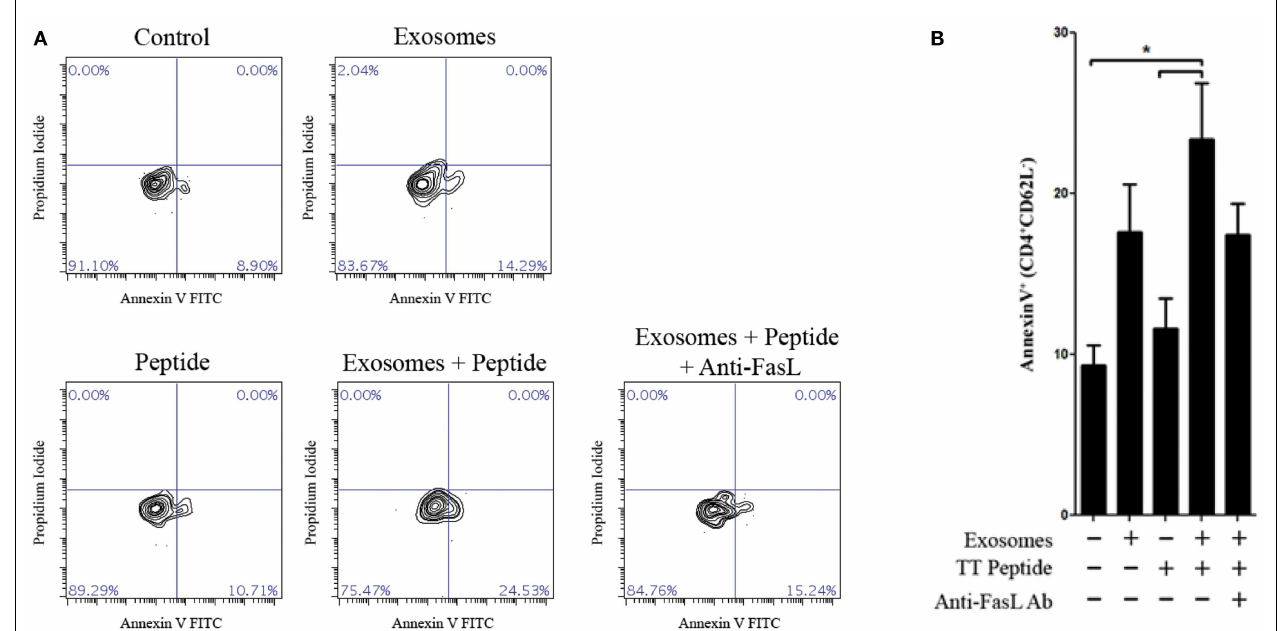
some wells to block interactions between exosome FasL and Fas on the target cells. Apoptosis in activated CD4 + CD62L neg T cells was assessed by annexin-V/propidium iodide staining.Two additional experiments with the same donor cells showed the similar trends but were less robust, presumably due to the loss of tetanus-specificT cells in vivo as the time after vaccination increased. (A) Representative contour plots of annexin-V and propidium iodide staining among CD4 + CD62L low -gatedT cells. (B) Frequency of annexin-V + cells (mean ± SEM of triplicate samples) among CD4 + CD62L low T cells. * p <